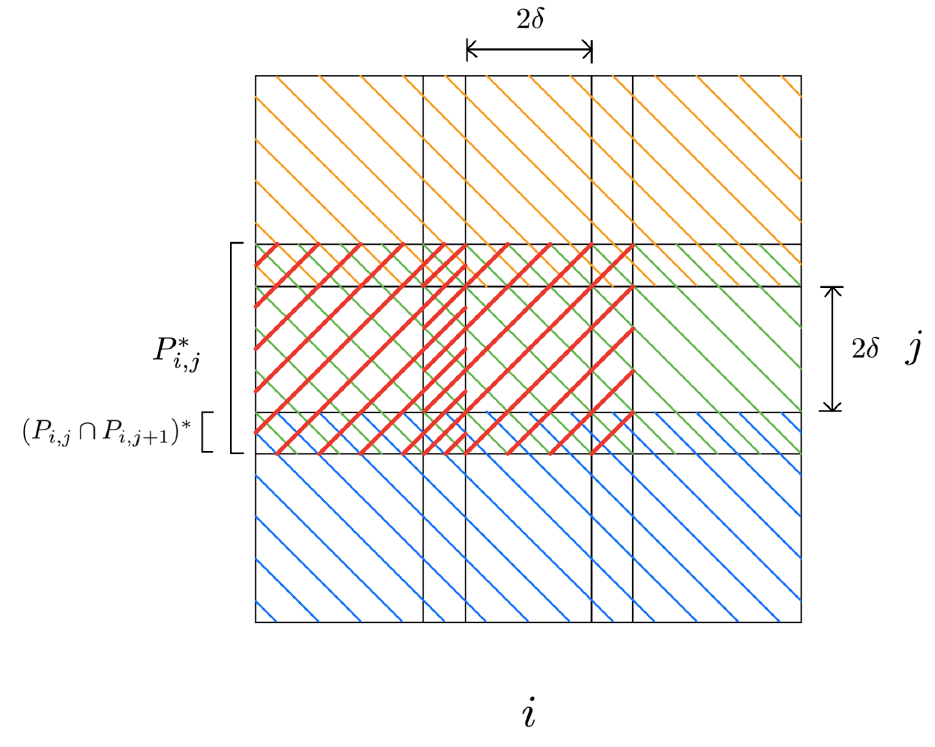
Figure 2. An illustration of the planar grid-like